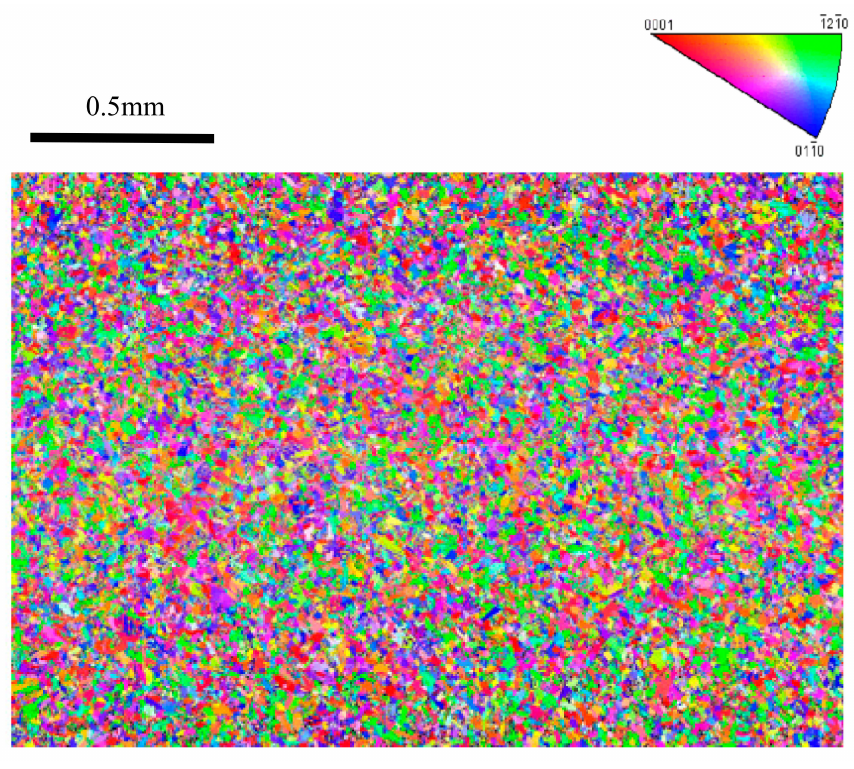
Figure 17. EBSD orientation map obtained from Ti-834 bar stock material.